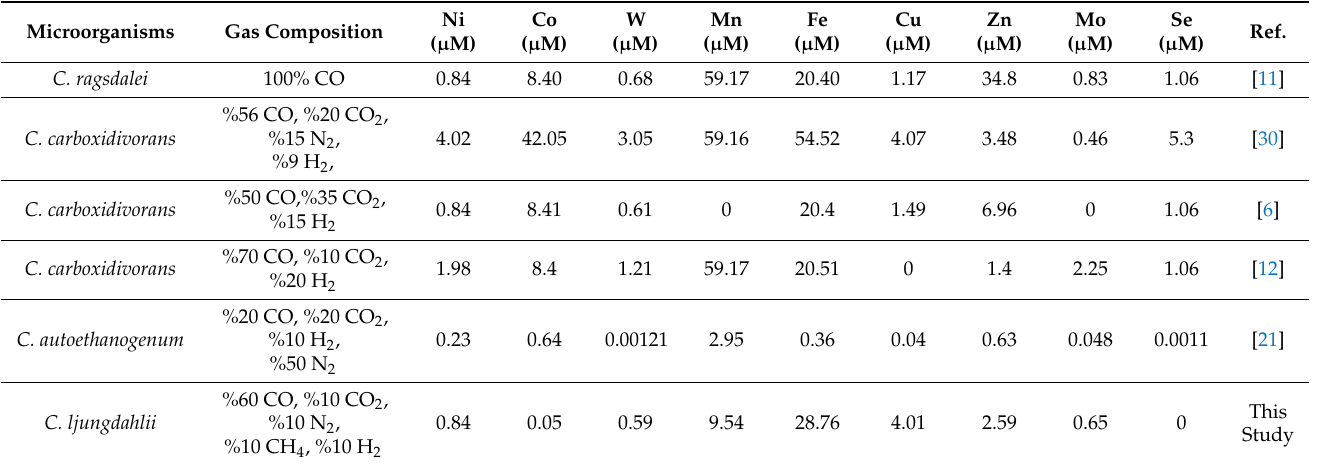
Table 7. Optimal amount of transition metal and Selenium compositions reported in various studies.